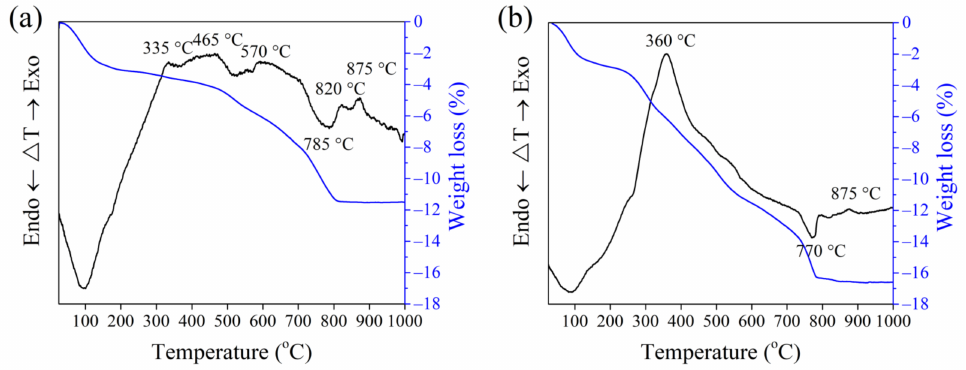
Figure 7. DTA curves of ceramic bodies ( a ) CS and ( b ) CD20, fired up to 1000 ◦